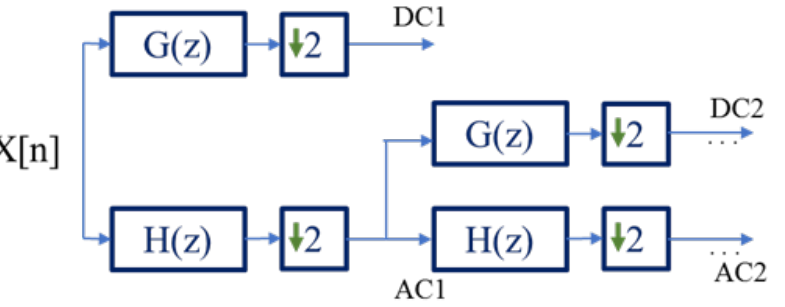
Figure 5. Algorithm of DWT decomposition through filter bank, where X[n] is the input signal, AC1, DC1 and AC2, DC2 represent two levels of decomposition of X[n], respectively.